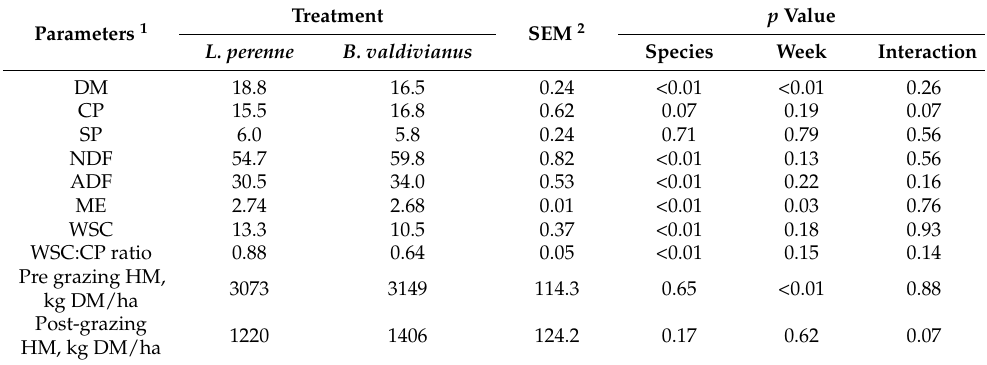
Table 1. Chemical composition of Lolium perenne and Bromus valdivianus during the